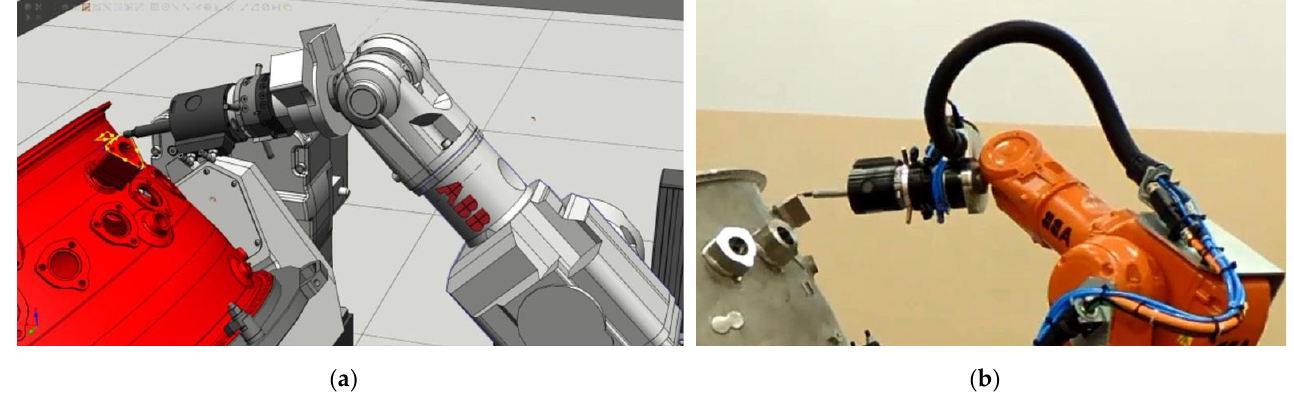
Figure 5. Model of edge deburring in dependent movements: ( a ) Robot Studio software; ( b ) real object. 0313.03.Z5 Lukas) and conical milling cutter (HFM 0307.03.Z7). In further parts of the